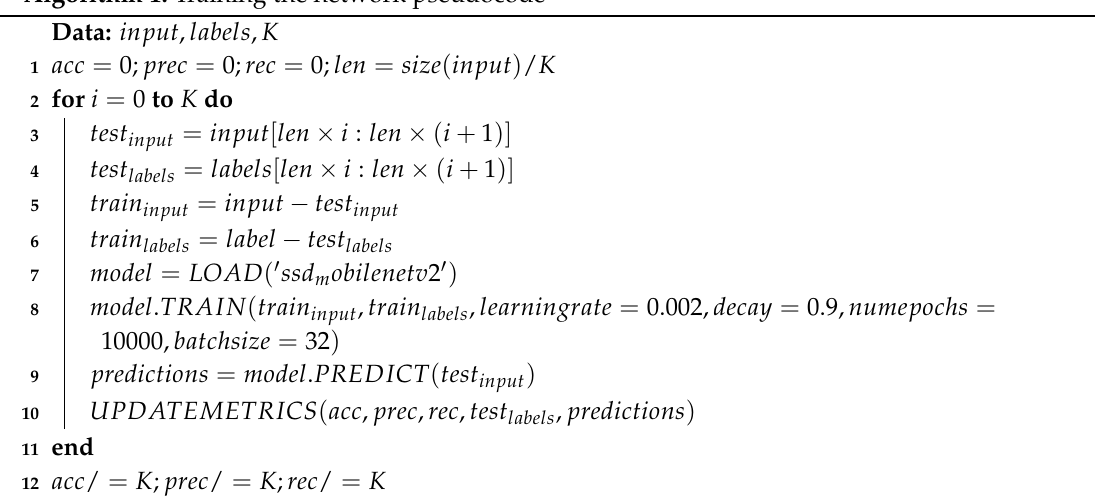
Algorithm 1: Training the network